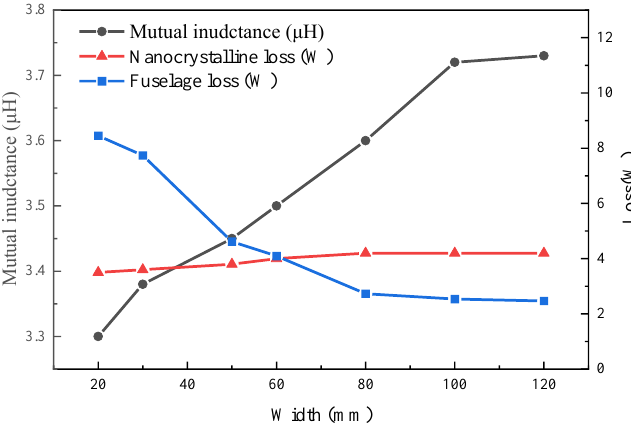
Figure 15. Mutual inductance and loss vs. width.